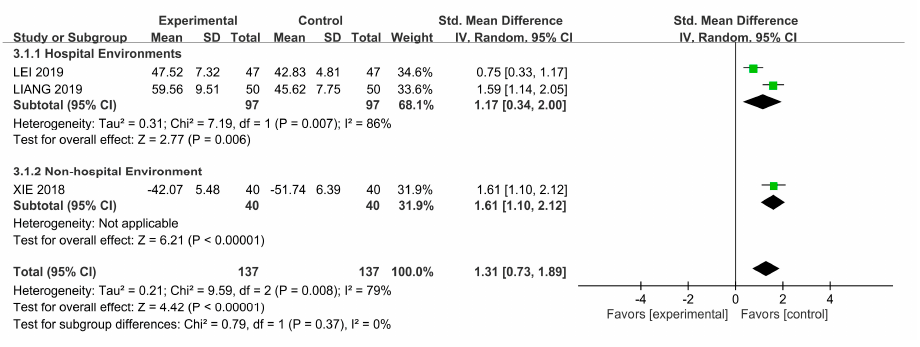
Figure 6. Effects on quality of life.